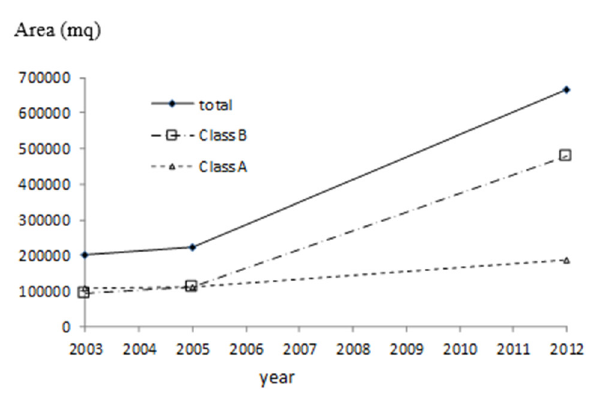
Figure 6. Total area occupied by vegetation of classes A and